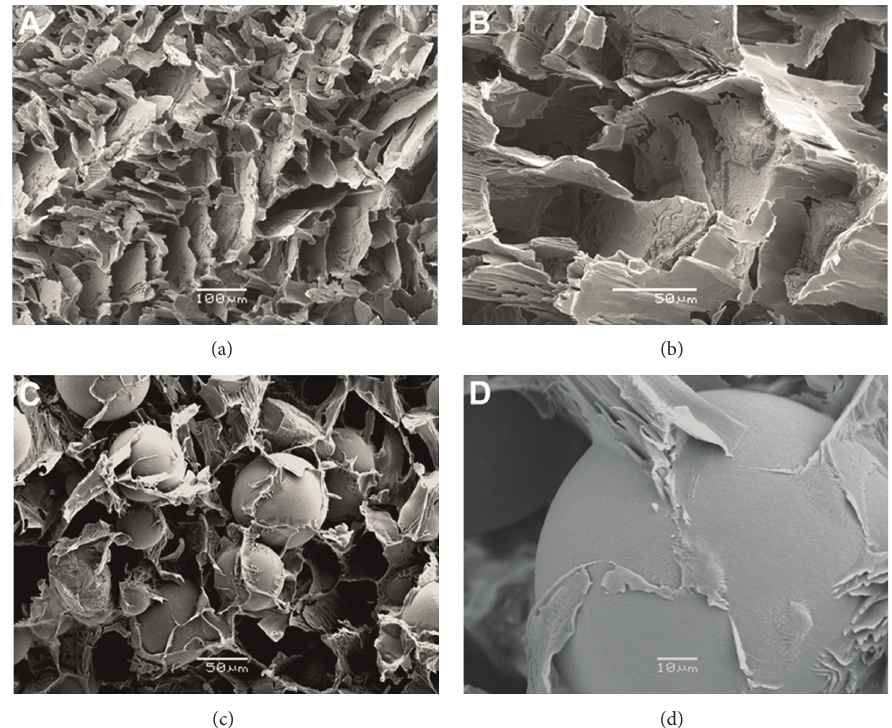
Figure 1: Scanning electron micrographs of plain PVA cryogels (a)-(b) and PVA-based composite cryogels loaded with 125mg PS-DVB microparticles (c)-(d).